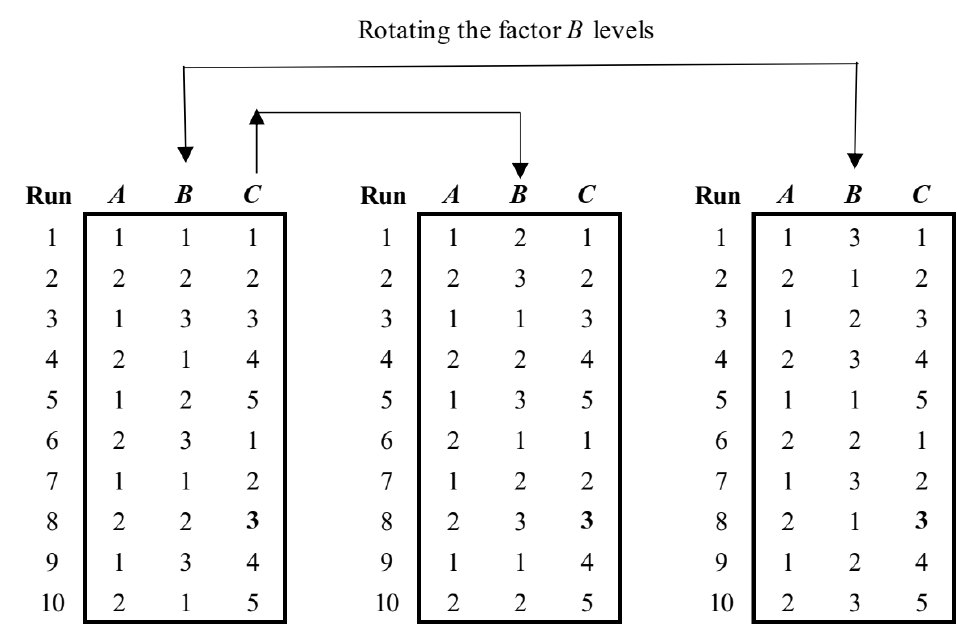
Figure 5. Sequential assembly of fraction.